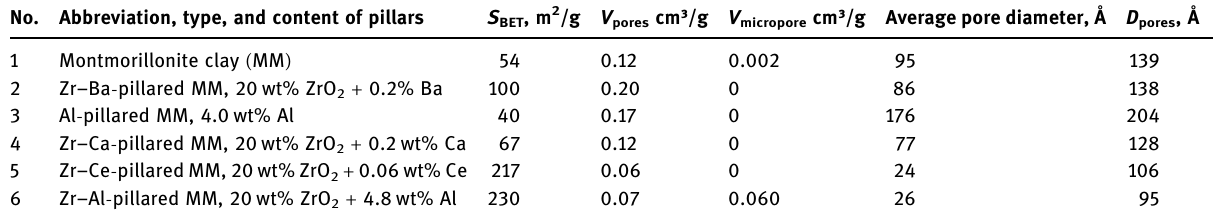
Table 2: Textural characteristics of pillared clays No. Abbreviation, type, and content of